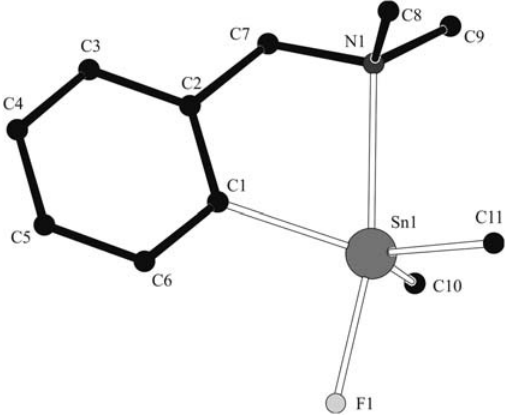
Figure 3 Molecular structure of compound 5 , hydrogens are omit- ted for clarity. Selected interatomic distances [ Å ] and angles [ ° ]: Sn1-F1 2.0384(10), Sn1-N1 2.4899(14), F1-Sn1-N1 167.37(5);